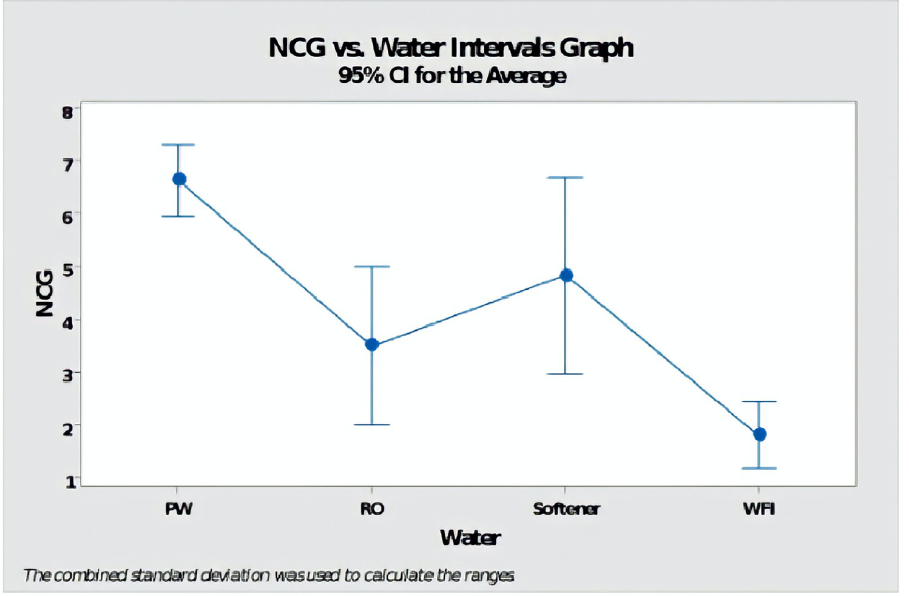
Fig 2. Interval plot of NCGs concentration versus types of water used for steam generation.